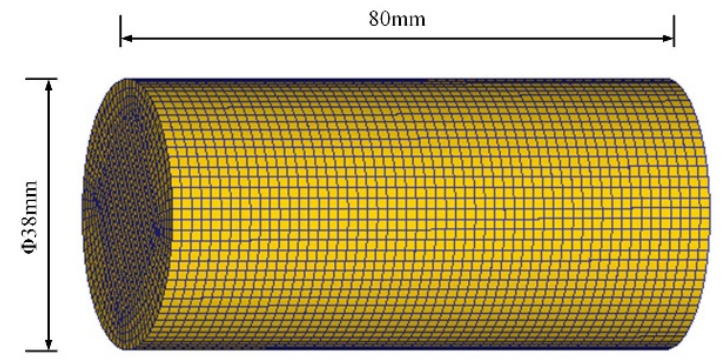
Figure 5. Three-dimensional finite element (FE) model of the specimen. Microstructural evolution is not a major concern in the FE simulation of hot forging; thus, hot forging numerical theory only considers the coupling effect of the temperature and stress/strain fields. The coupling effect between the temperature and stress/strain evo- lution is described as follows. On the one hand, the plastic-deformation work accumulated in forging is converted into an internal heat source at a certain proportion. On the other hand, because of the existence of a temperature gradient, the expansion is different. Finally, a thermal strain is induced.